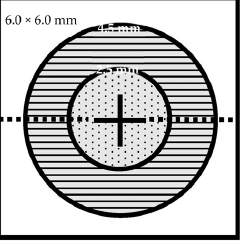
Figure 2. Disc OCT/OCTA cube 6.0 mm × 6.0 mm scan field. Analysis parameters: whole image (WI) (6.0 mm × 6.0 mm), inside disc (ø 2.5 mm), peripapillary (ø 2.5–4.5 mm). Legend: ø, diameter.